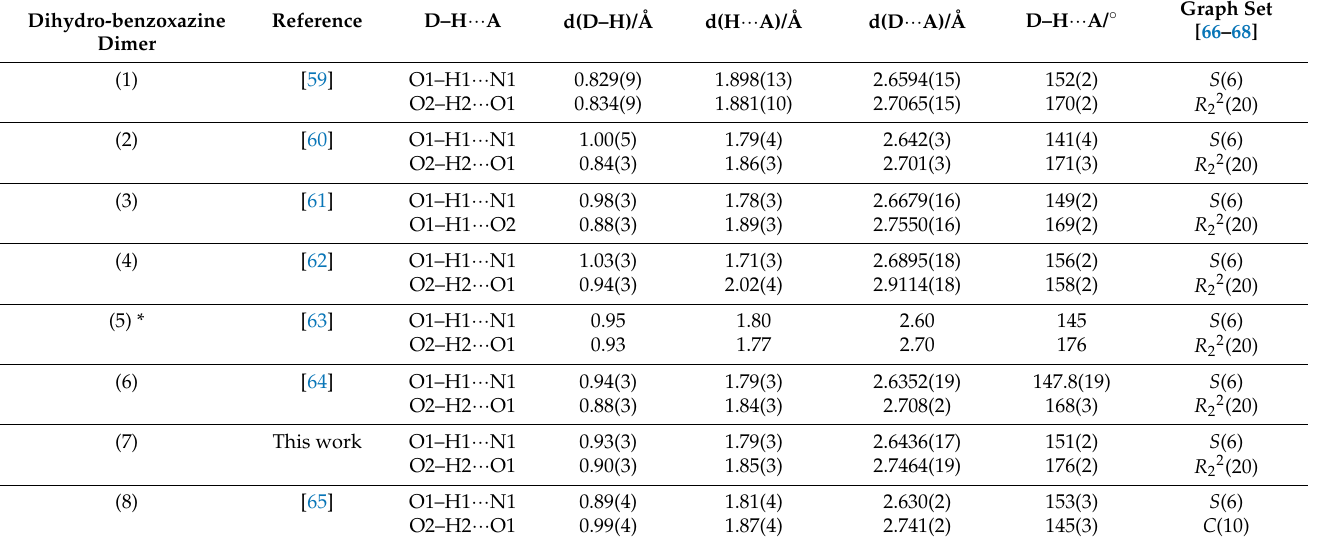
Table 3. Geometries of O–H ··· N and O–H ··· O hydrogen bonding interactions (Å, ◦ ). Dihydro-benzoxazine Reference Dimer